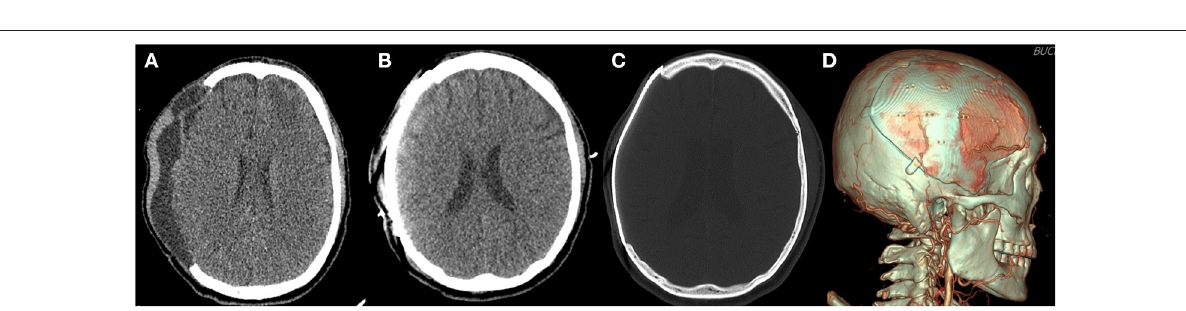
FIGURE 2 | Three-dimensional (3D) printed patient-specific titanium implant. (A) The preoperative computed tomography scan of a patient with subgaleal and epidural fluid collection before cranioplasty. (B) The immediate postoperative computed tomography scan reveals no postoperative fluid collection after surgical evacuation during cranioplasty. (C) Bone setting view. (D) 3D reconstructed